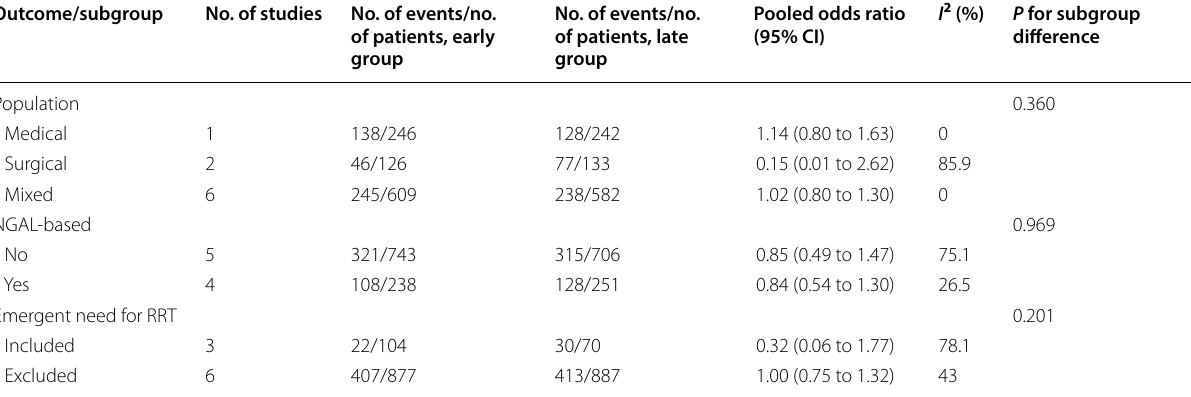
Table 1 Subgroup analysis of mortality in the included randomized controlled trials